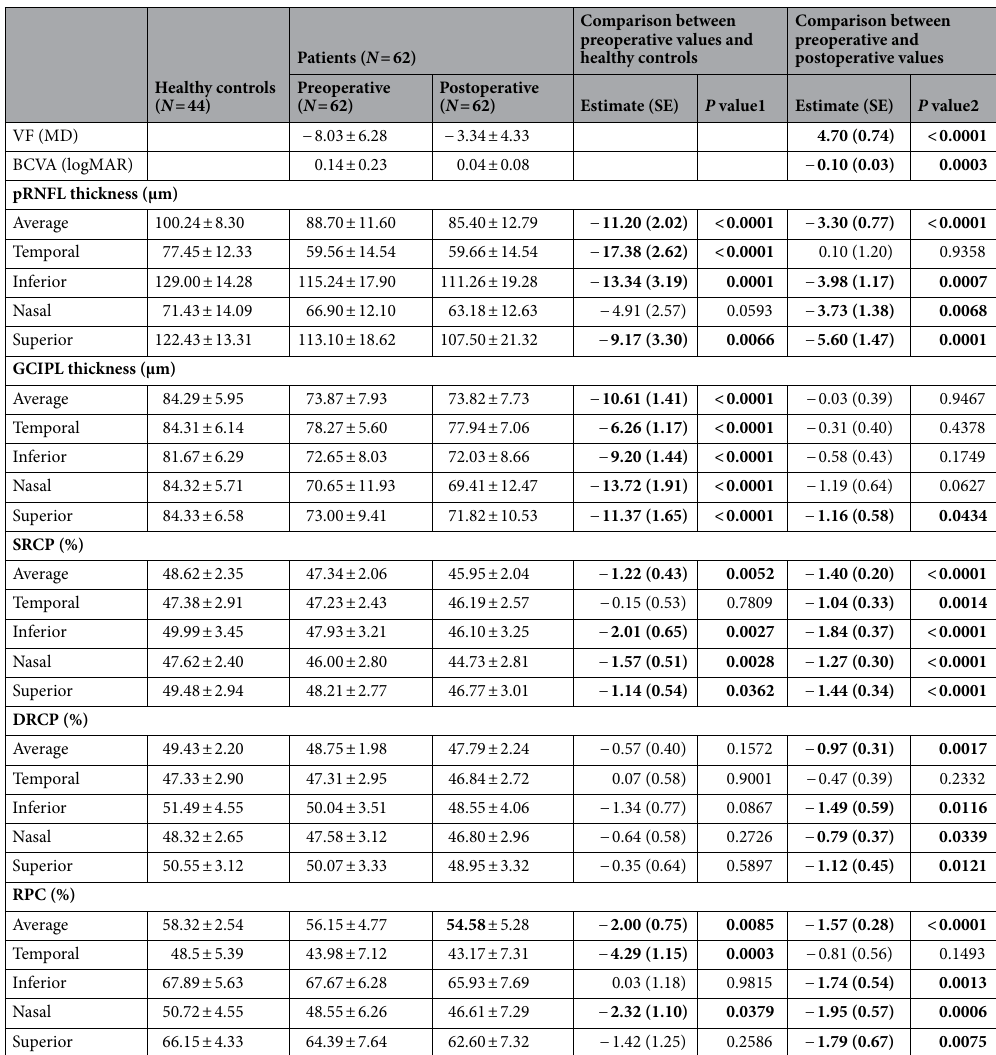
Table 2. Comparison of intraretinal layer thickness and parafoveal and peripapillary vessel densities in patients and healthy controls. Significant values are indicated in bold. N numbers, VF visual field, MD mean